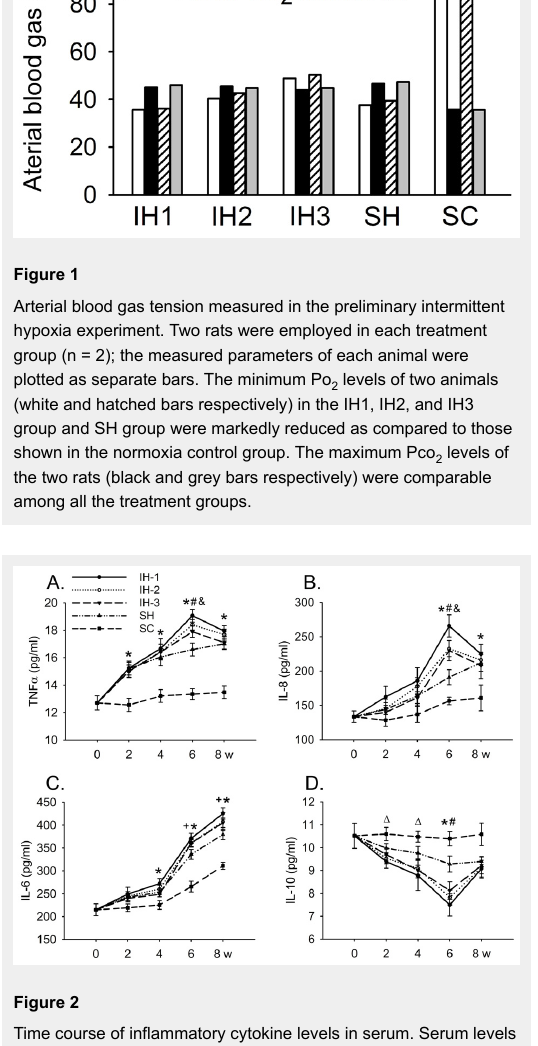
Time course of inflammatory cytokine levels in serum. Serum levels of TNF-α (A), IL-8 (B), IL-6 (C), and IL-10 (D) were measured in the IH1 (n = 7), IH2 (n = 8), IH3 (n = 8), SH (n = 8) and SC group (n = 8) at each time point. The data were plotted as mean ± SE. Results of two-way ANOVA statistical analyses were labeled. * p <0.05 IH1, 2, 3 and SH groups vs the SC group; # p <0.05 IH 1, 2, 3 vs the SH group; & p <0.05 IH1 vs IH3 group; + p <0.05 IH1 vs SH group; ∆ p <0.05 IH1, 2 and 3 vs SC